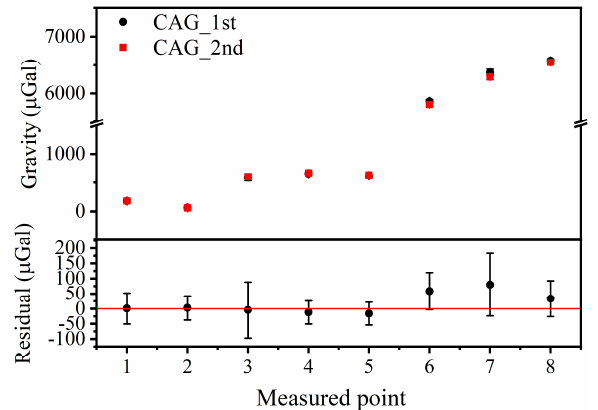
Figure 5. The gravity data of 8 measured points for two measurements (the black and red dots represent the results of first and second measurements, respectively) with the home-made, truck- borne CAG system, the residual data are also shown in the figure below.